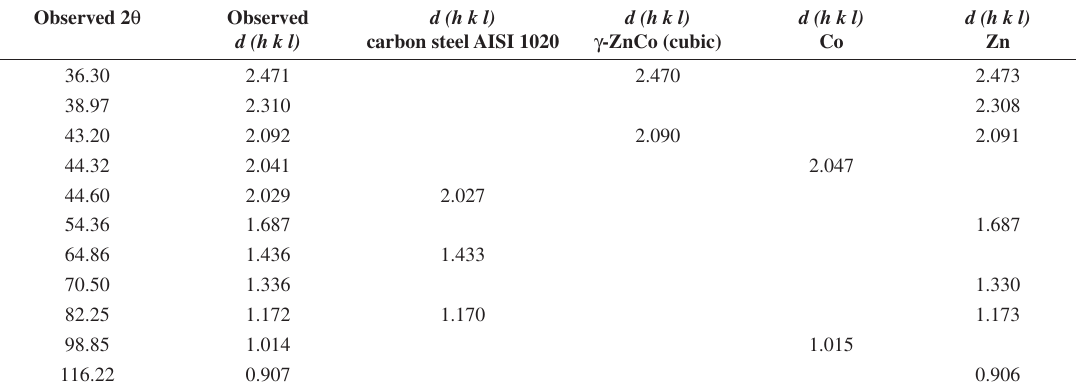
Table 4. d ( h k l ) values for the Zn-Co coatings produced from the selected experiments of Table 2.